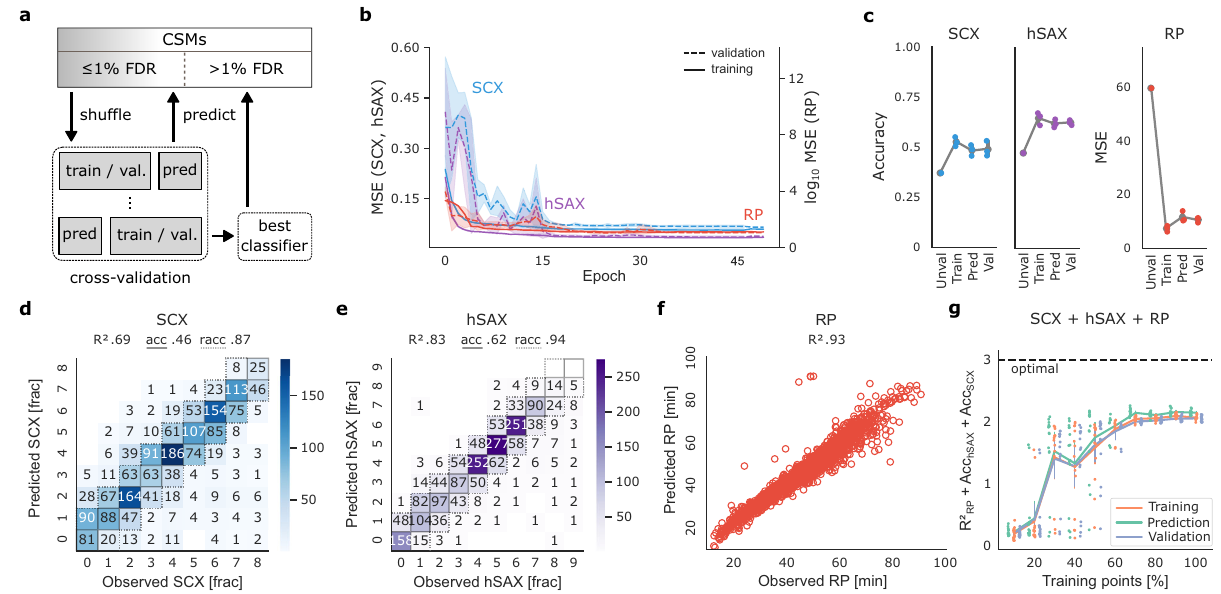
Fig. 2 Cross-validation of retention time prediction. a Applied cross-validation (CV) strategy in xiRT. To predict the retention times of CSMs excluded from training, the best CV classi fi er is used. b xiRT performance over training epochs for strong-cation exchange chromatography (SCX, blue), hydrophilic strong-anion exchange chromatography (hSAX, purple), and reversed-phase chromatography (RP, red) prediction with k = 3 CV-folds. Shaded areas show the estimated 95% con fi dence interval with the dashed/solid line representing the mean for the validation/training data, respectively. c xiRT performance across different metrics (error bars show standard deviation with the mean as center) for k = 3 CV folds. Prediction for the “ unvalidated ” data was only performed once. d – f Prediction results from a representative CV iteration for SCX, hSAX, and RP at 1% CSM-FDR. The achieved R 2 , accuracy (acc) and relaxed accuracy (racc) are given at the top. g Learning curve with increasing number of CSMs, e.g., 10% (645 total CSMs, 387 for training, 43 for validation, 215 for prediction), 50% (3226, 1935, 216, 1075), 100% (6453, 3871, 431, 2151); bars indicate standard deviation with the line representing the mean for the training (red), prediction (green), and validation (blue) data. Source data are provided as a Source Data fi